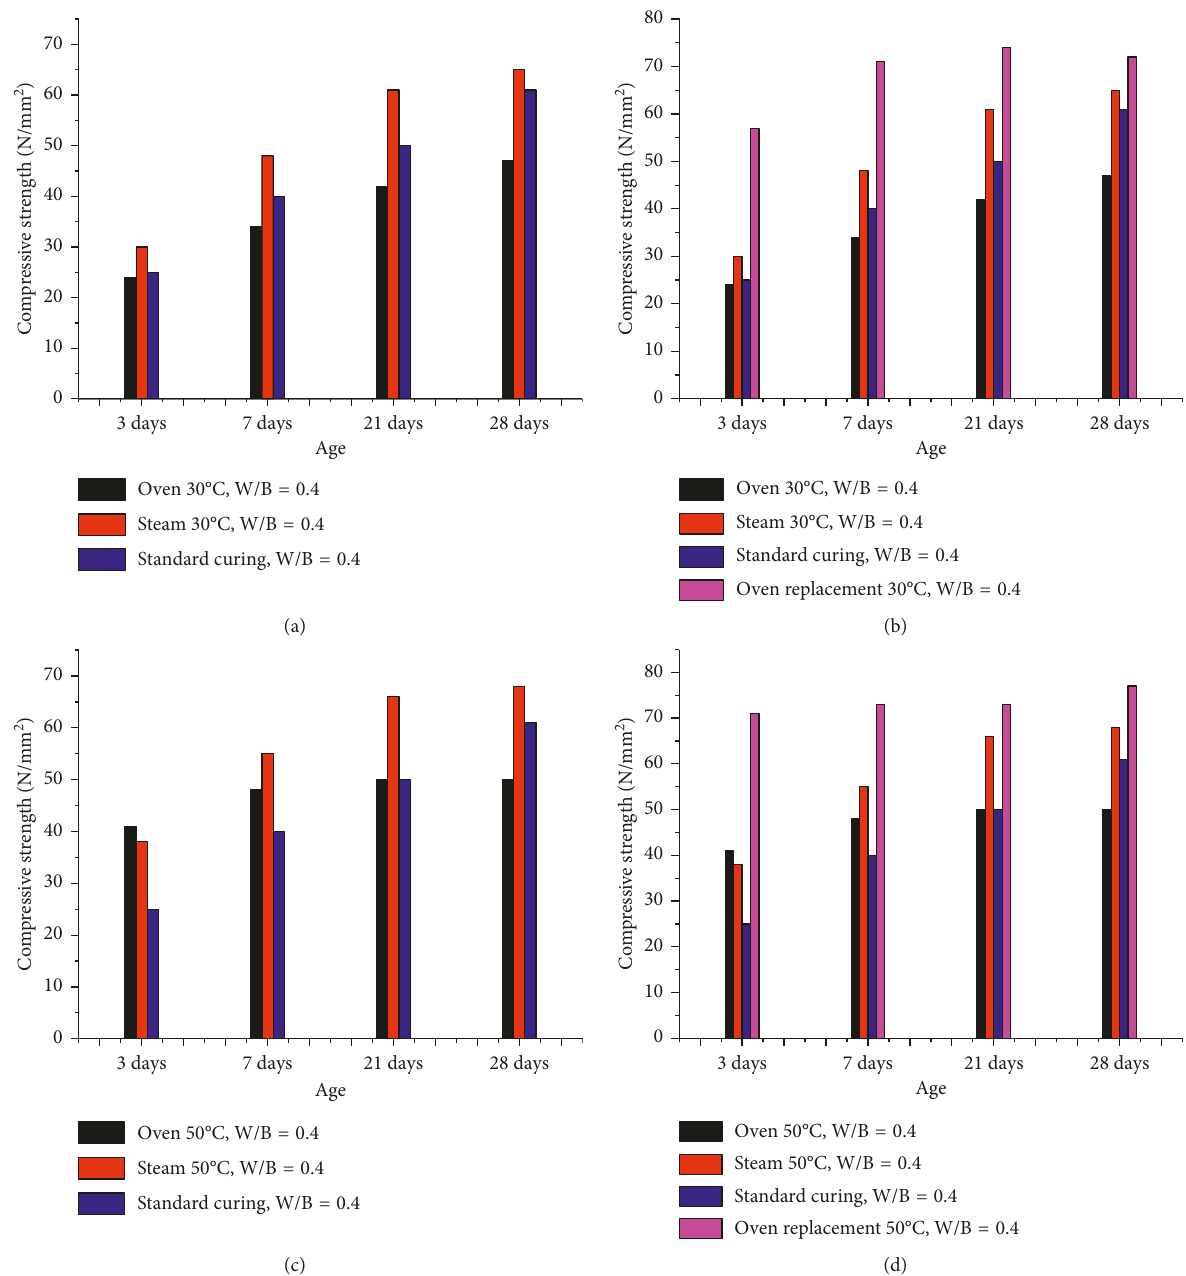
Figure 3: (a) Compressive strengths of concrete specimens with a W/B ratio of 0.4 prepared and cured under different conditions at a temperature of 30 ° C. (b) Compressive strengths of concrete specimens with a W/B ratio of 0.4 prepared and cured under oven replacement compared with different conditions at a temperature of 30 ° C. (c) Compressive strengths of concrete specimens with a W/B ratio of 0.4 prepared and cured under different conditions at a temperature of 50 ° C. (d) Compressive strengths of concrete specimens with a W/B ratio of 0.4 prepared and cured under oven replacement compared with different conditions at a temperature of 50 °